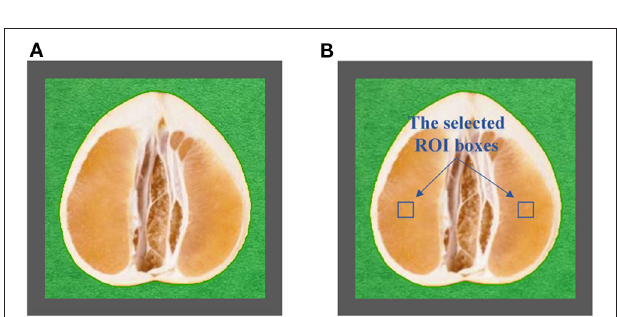
FIGURE 2 | The central longitudinal cut view of the equipped pomelo sample (A) and the selected ROI areas (B)